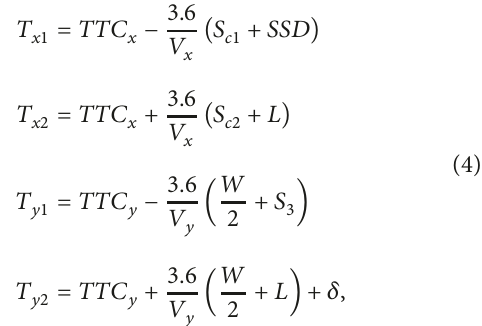
Figure 3. To ensure safety, the distance from the major